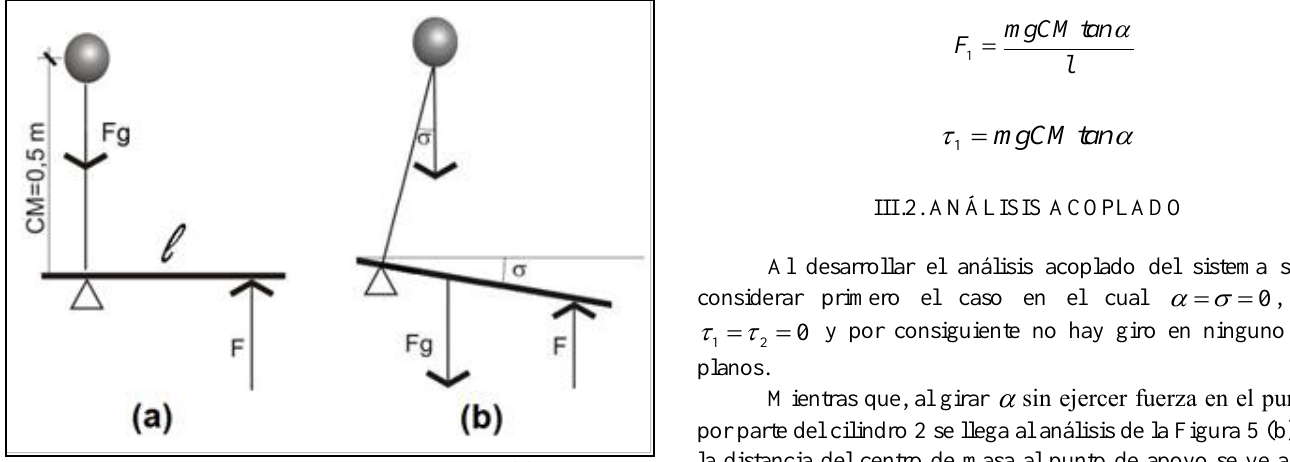
Figura 3: Vista perpendicular al Plano B (a) con masa concentrada en el centro de masa (b) girada con ángulo σ. Fuente: Autores, (2015).